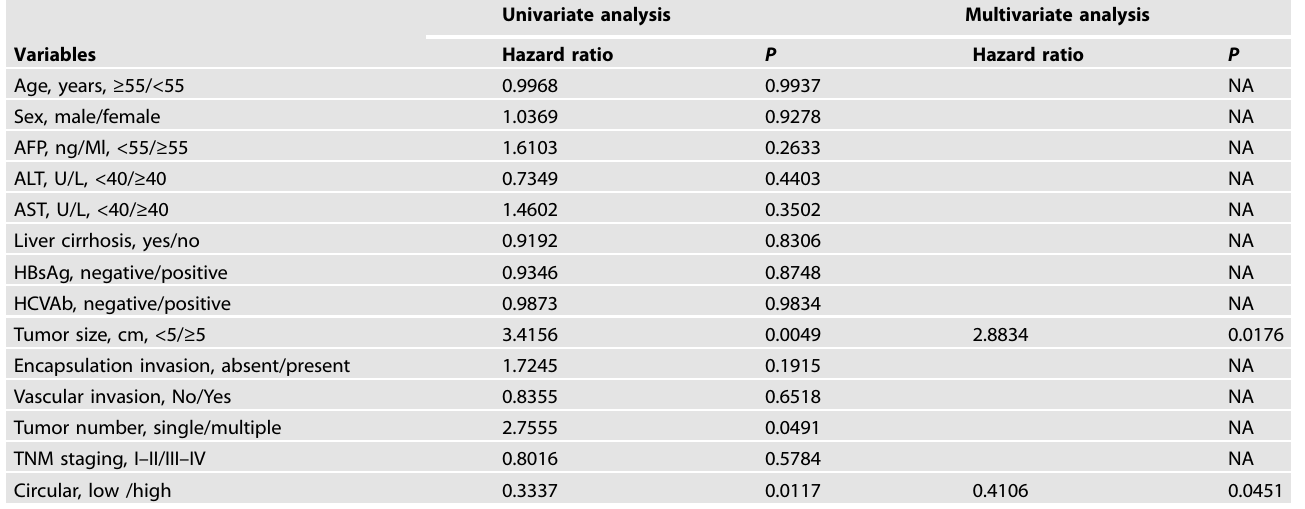
Table 3. Univariate and multivariate analysis for overall